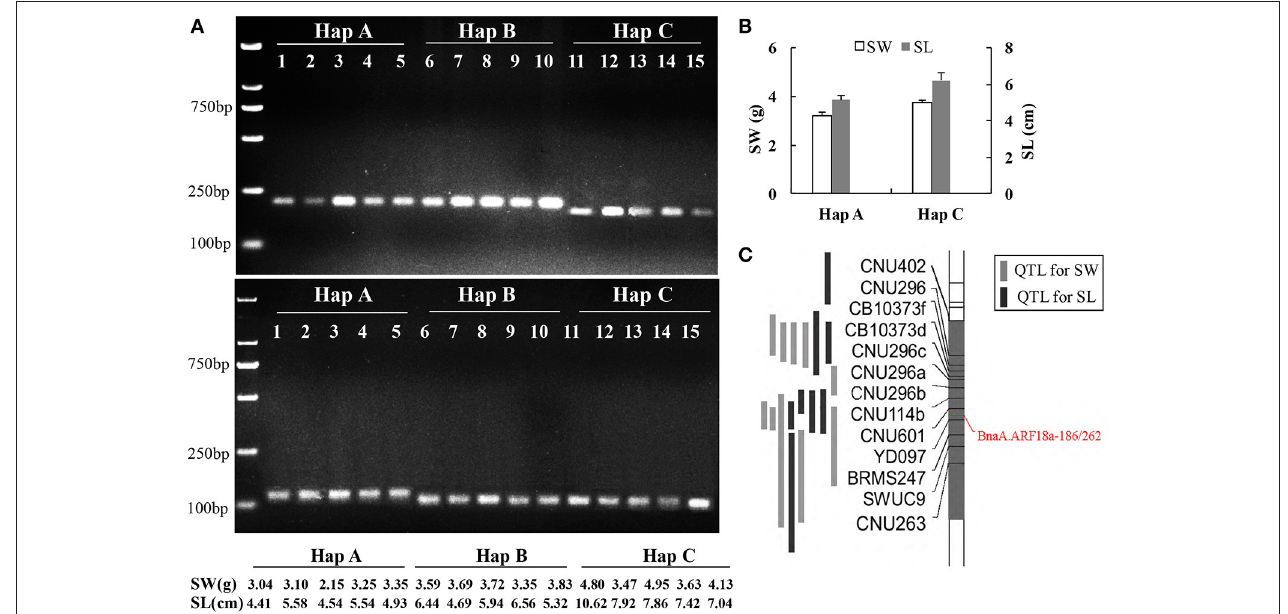
FIGURE 6 | Association of SNPs with seed weight and silique length revealed with dCAPS. Screening accessions in the natural population using BnaA.ARF18a -186 (up) and BnaA.ARF18a -262 (below) (A) ; Haplotype analysis (B) and location of dCAPS in the interval of QTL for seed weight and silique length (C) in a DH population ( Fu et al.,